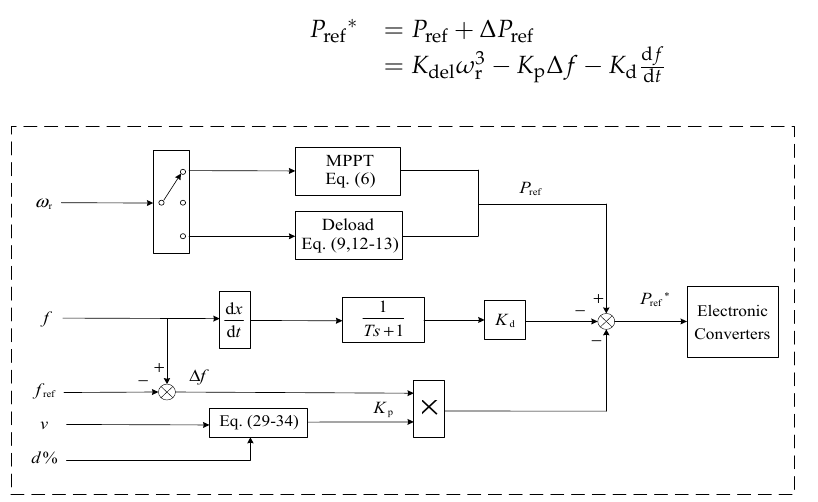
Figure 5. Configuration of active power reference.